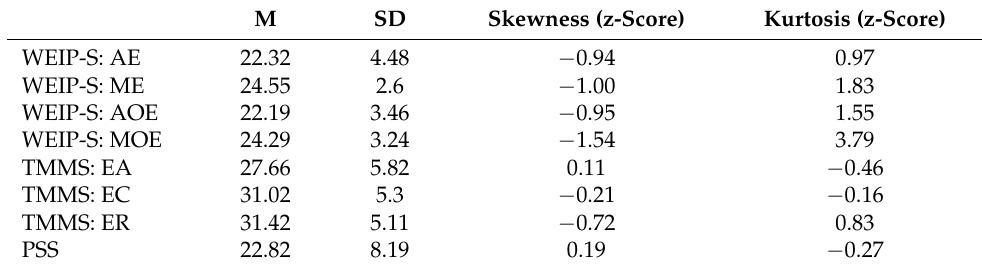
Table 2. Descriptive statistics for psychological tests.